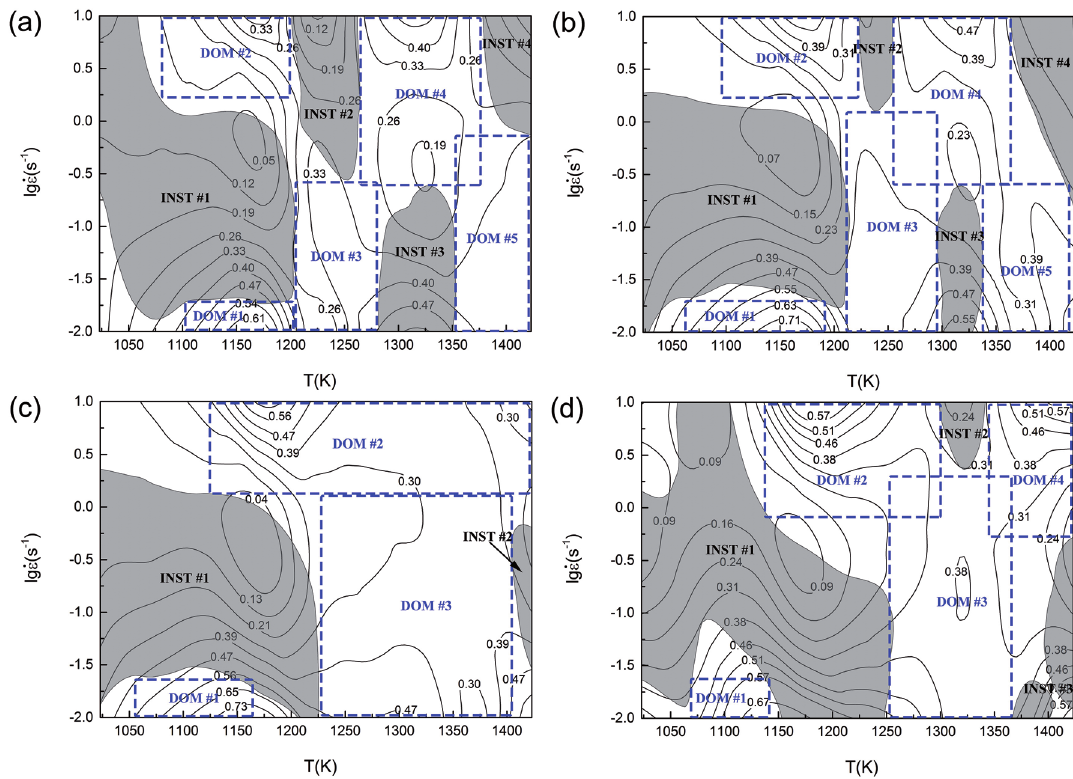
Figure 8: The processing map of Ti-6Al-4V-0.1Ru at the strain of (a) 0.2; (b) 0.4; (c) 0.6; (d) 0.8. maps shown in Figure 8, the η -values are about 0.19, 0.40, 0.54 and 0.61 at the corresponding deformation conditions where is marked as DOM #1, which indicates that high power dissipation efficiency relates to violent